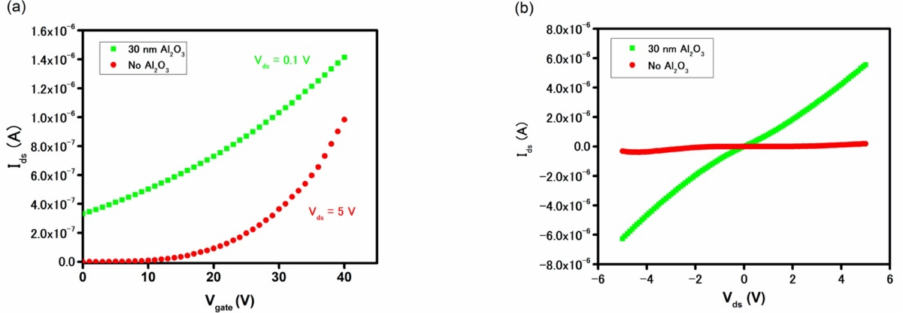
Figure 5. ( a ) FET characteristics curve and ( b ) drain current characteristics curve (V gate = 0 V) of MoS 2 -based device with and without passive Al 2 O 3